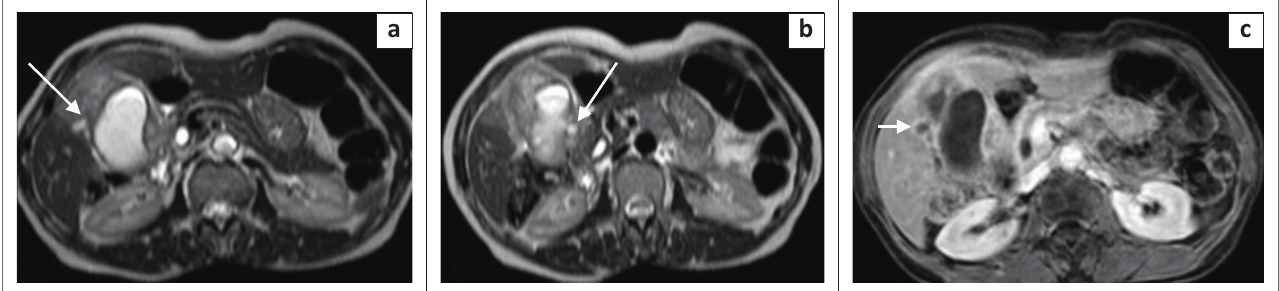
FIGURE 3: (a and b) Axial T2W magnetic resonance imaging images demonstrating hyperintense intramural nodules (arrows), which on post-contrast T1W sequence (c) shows peripheral enhancement (black arrow), suggestive of a microabscess.